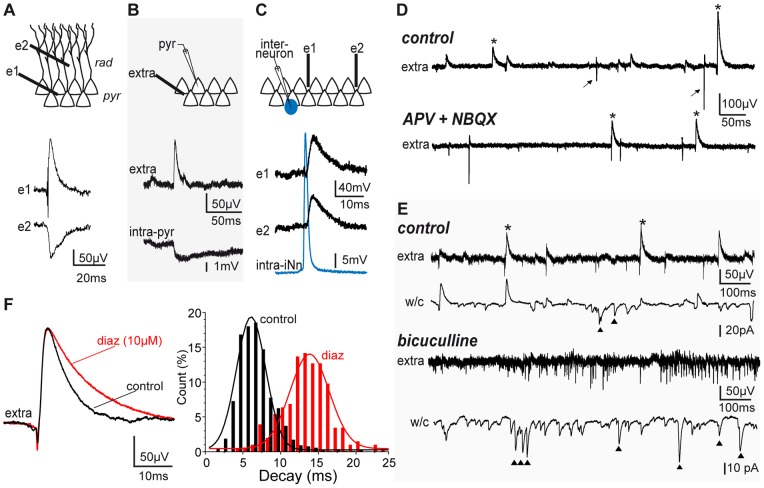
Extracellular recording of spontaneous inhibitory post-synaptic potentials (eIPSPs) in CA3.A. Simultaneous extracellular recording (guinea pig) from CA3 strata pyramidale (e1, pyr) and radiatum (e2, rad) of spontaneous eIPSPs in vitro. Note eIPSP reversed polarity in radiatum. B. Simultaneous intracellular (from a pyramidal neuron, intra-pyr) and extracellular (extra) recording of an inhibitory synaptic event (guinea pig). C. Simultaneous extracellular recording (e1 and e2, separated by about 150 µm) of eIPSPs evoked by the spontaneous firing of a single action potential from an intracellularly recorded interneuron (intra-iNn), which soma was located at the oriens/pyramidale border (guinea pig). D. Spontaneous extracellular activity in the pyramidal layer (guinea pig): eIPSPs, of positive polarity (upper trace, *), are easily distinguishable from multi-unit activity (arrows). Upper trace, control. Lower trace, in presence of the NMDA and AMPA/KA glutamatergic receptor blockers APV+NBQX. E. Spontaneous activity (control) simultaneously recorded in extracellular (extra) and patch clamp (w/c, whole cell voltage clamp at −50 mV from an individual nearby pyramidal neuron) in a P21 rat. Due to ECl-, GABA-A currents are outward while glutamatergic currents (triangles) are inward. Note that in presence of bicuculine (bicu), eIPSPs and IPSPs are no longer observed, in spite of intense neuronal activity visible as multi-unit discharge (upper trace, extra) and high-frequency glutamatergic synaptic events (lower trace, w/c, triangles). F. Comparison of eIPSP decay (left, average trace normalized on amplitude, right, histogram distribution of eIPSPs decay times) in control (black) and in presence of diazepam (red) in a guinea pig. Note prolonged eIPSP decay under diazepam.